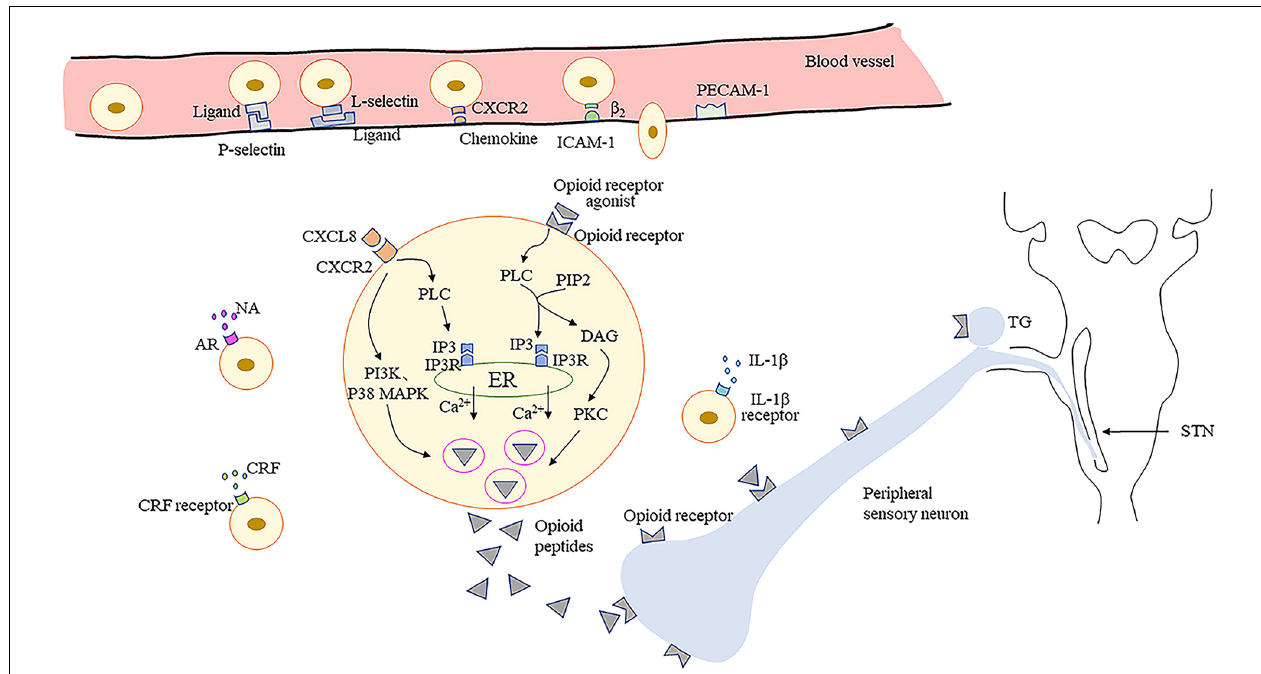
FIGURE 1 | Migration of opioid peptide-containing immune cells and release of opioid peptides within peripheral inflamed or damaged tissues. Opioid peptide-containing immune cells migrate into inflamed or damaged tissues mediated by adhesion molecules. Release of opioid peptides is triggered by chemokines, inflammatory mediators or NA. Opioid peptide secretion is regulated predominantly by IP3R-triggered Ca 2 + release from ER, partially by PI3K, and by p38 MAPK. Then opioid peptides bind to opioid receptors on peripheral terminals of sensory neurons resulting in pain inhibition. ICAM-1, intercellular adhesion molecule-1; PECAM-1, platelet-endothelial cell adhesion molecule-1; CRF, corticotropin-releasing factor; IL-1 β , interleukin-1 β ; CXCR2, the CXC chemokine receptor 2; NA, noradrenaline; AR, adrenergic receptors; PLC, phospholipase C; PIP2, phosphatidylinositol-4,5-bisphosphate; IP3, inositol-3 phosphate; DAG, diacylglycerol; IP3R, inositol-3 phosphate receptors; ER, endoplasmic reticulum; PKC, phosphokinase C; PI3K, phosphoinositol-3-kinase; p38 MAPK, p38 mitogen-activated protein kinase; TG, trigeminal ganglion; STN, spinal trigeminal